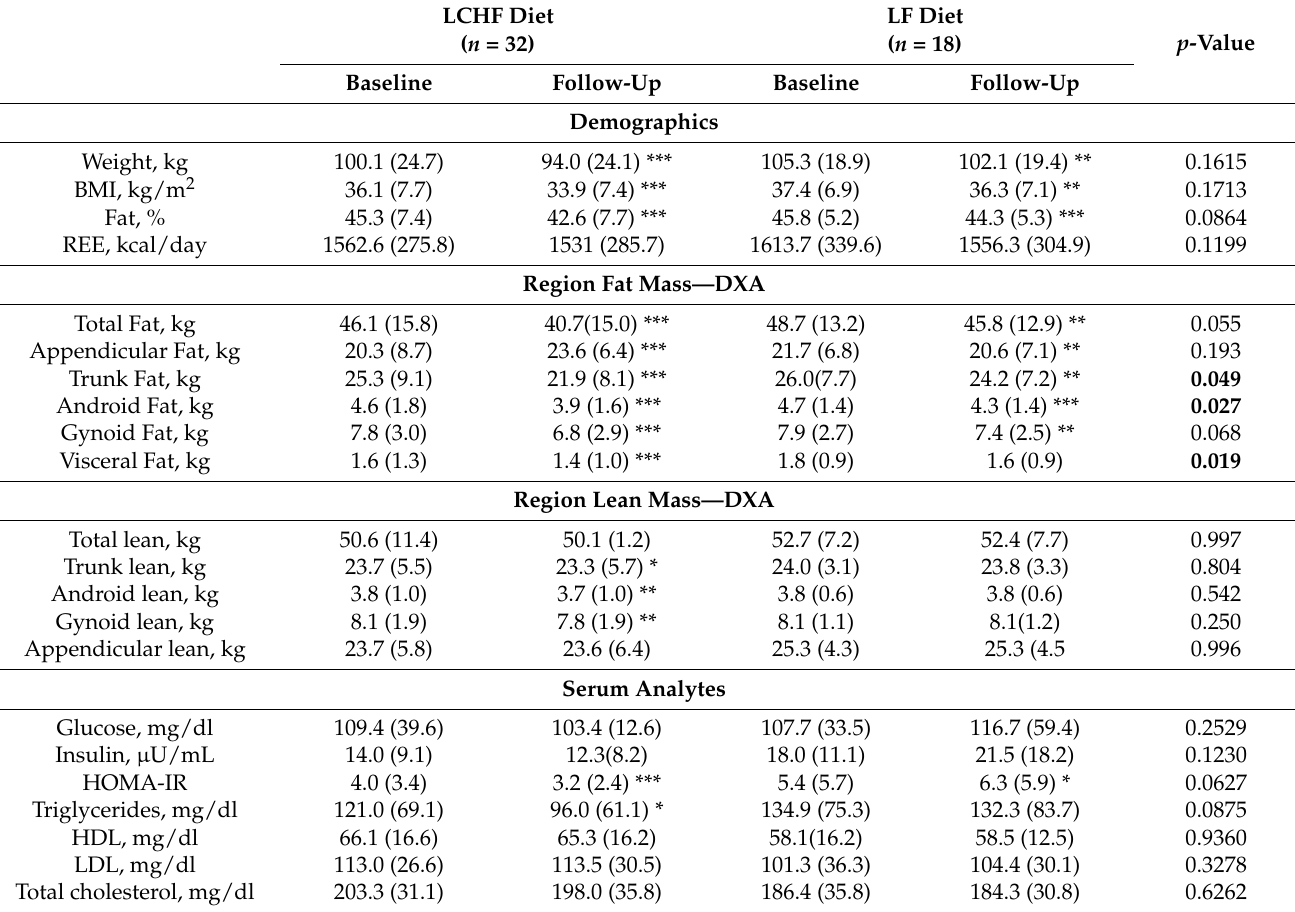
Table 2. Comparison of Baseline and Follow-Up (15 week) Measures by Paired t -test Within Each Diet Group and ANCOVA Between Diet